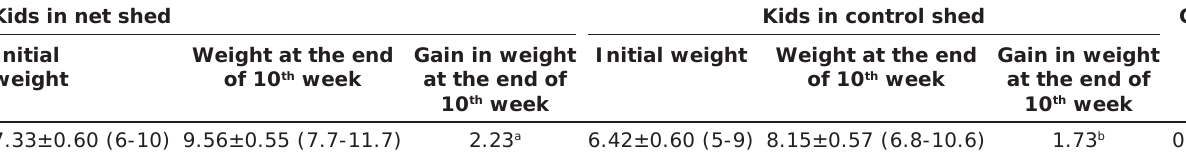
Table-8: Weight gains at the end of 10 th week in kids under net and control shed. Kids in net shed